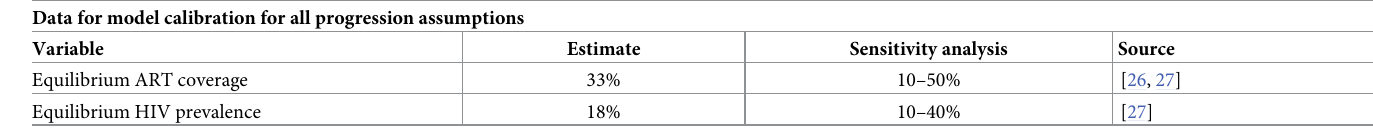
Table 3. Model fitting data: Baseline values, sensitivity analysis ranges, and